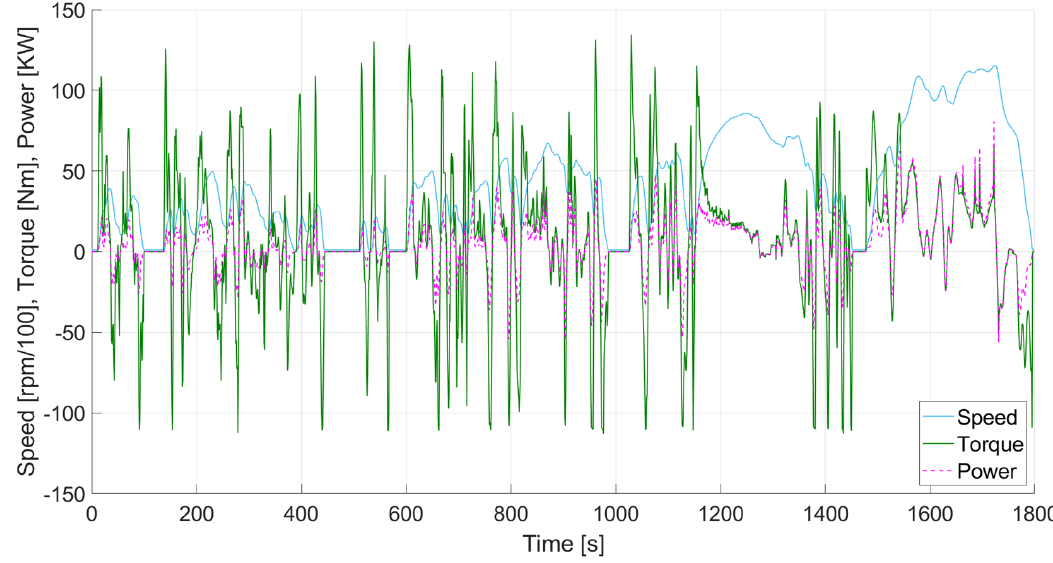
Figure 9. WLTP class 3 drive cycle: speed, shaft torque, and power vs. time. The efficiency, RMS stator phase current, and RMS stator phase voltage are shown in Figures 10 and 11 for the different winding technologies.